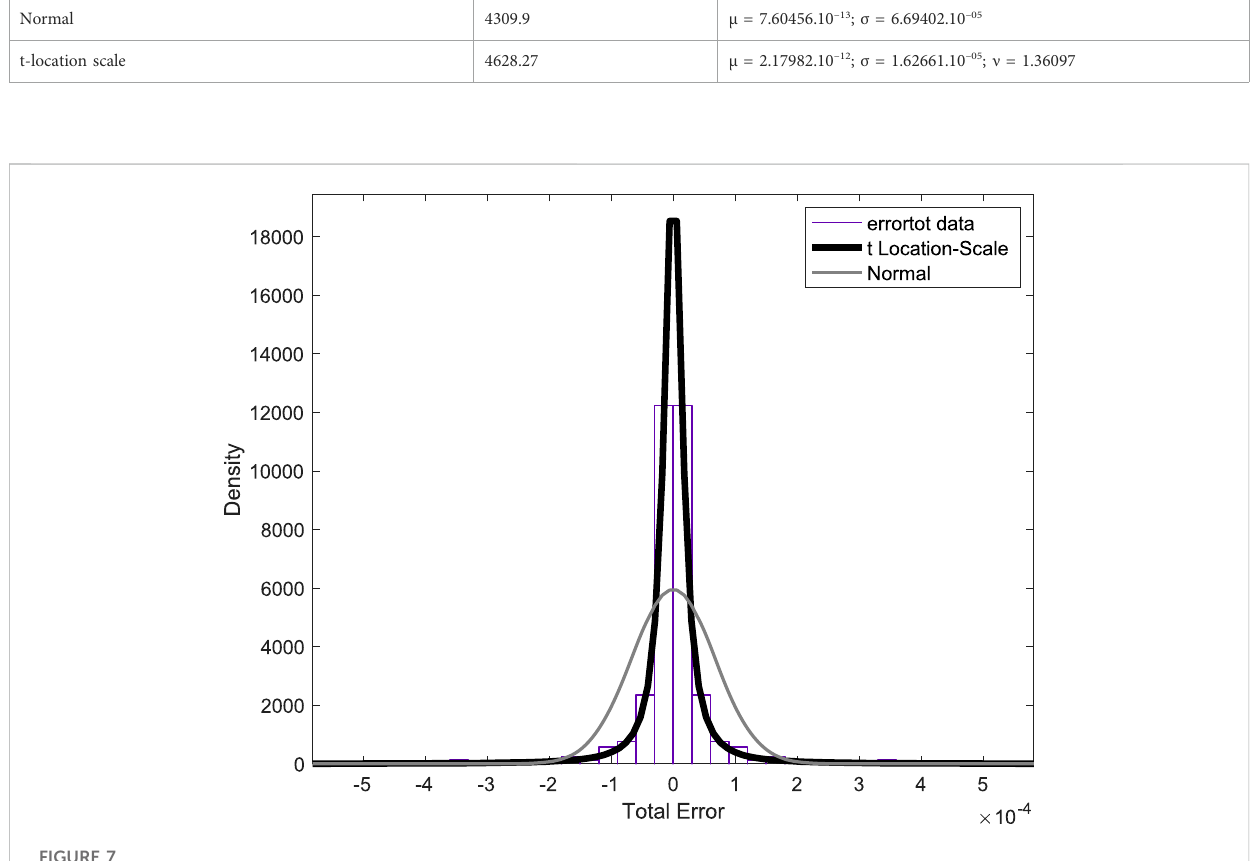
FIGURE 7 Normal and t-location scale pdf used for fi tting the distribution of